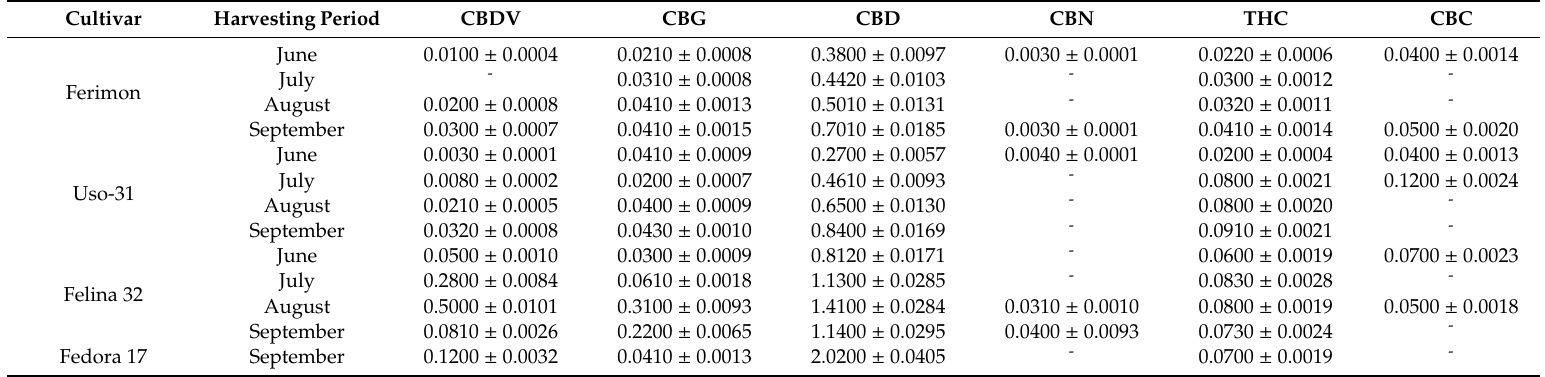
Table 2. UHPLC cannabinoids concentration in Ferimon, Uso-31, Felina 32 and Fedora 17 cultivars over the season. Results were reported as % ( w / w of dried sample) ± SD (standard deviation), n = 5.